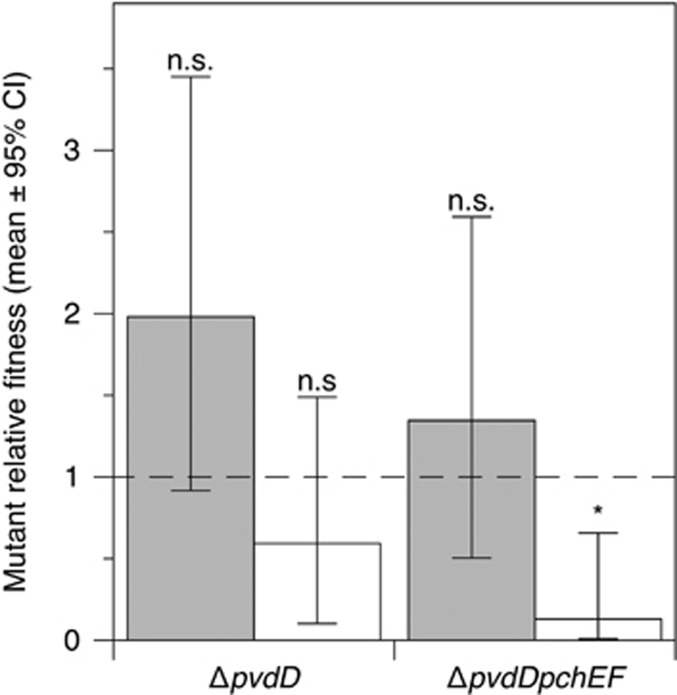
Relative fitness of ΔpvdD and ΔpvdDΔpchEF mutants in pure culture (grey bars) and in mixed culture with an isogenic wild type (white bars) in ex vivo pig lung+ASM after 96 h of growth. Bars show means of eight replicates spread across two replica experiments, with associated 95% confidence interval. (ANOVA eliminating experimental block: genotype F1,27=2.24, P=0.146; presence/absence of the wild type: F1,27=10.7, P=0.003; interaction term: F1,27=0.137, P=0.714). Neither strain had a relative fitness signficantly different from 1 in pure culture (post hoc t-tests, P=0.074 for ΔpvdD, P=0.472 for ΔpvdDΔpchEF). In co-culture, relative fitness was not significantly different from 1 for ΔpvdD (P=0.074), but <1 for ΔpvdDΔpchEF (P=0.007). In both panels, results of post hoc tests for relative fitness=1 are shown with *=P=0.007; n.s.=not significant.